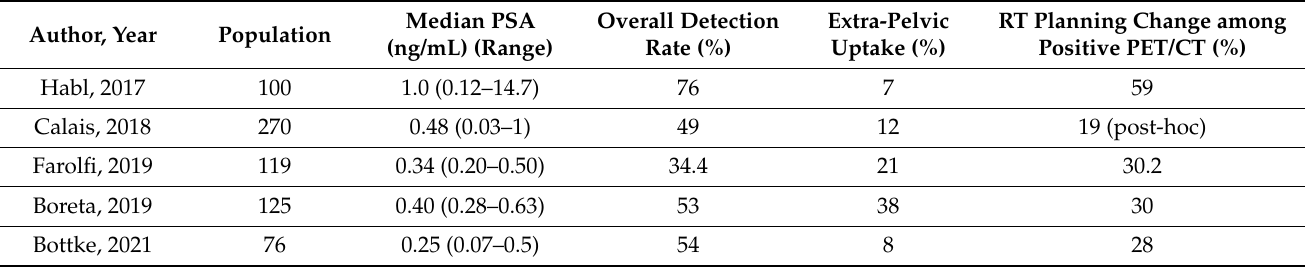
Table 3. Selected studies assessing the impact of 68 Ga-PSMA-11-PET/CT findings on the salvage RT